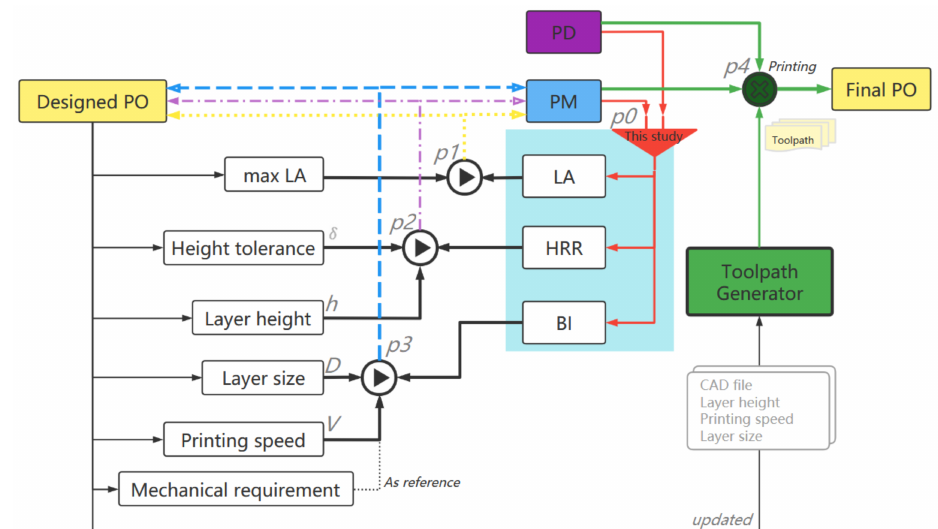
Figure 18. The application of this study in the process of 3D concrete printing. This study is at point p0 . P1 compares the LA from the designed PO and the existing PM and PD, and feeds back to optimize the PM or the designed PO, as well as p2 and p3 . Based on updated configurations, the final PO would be printed at p4 , from the newly generated toolpath.